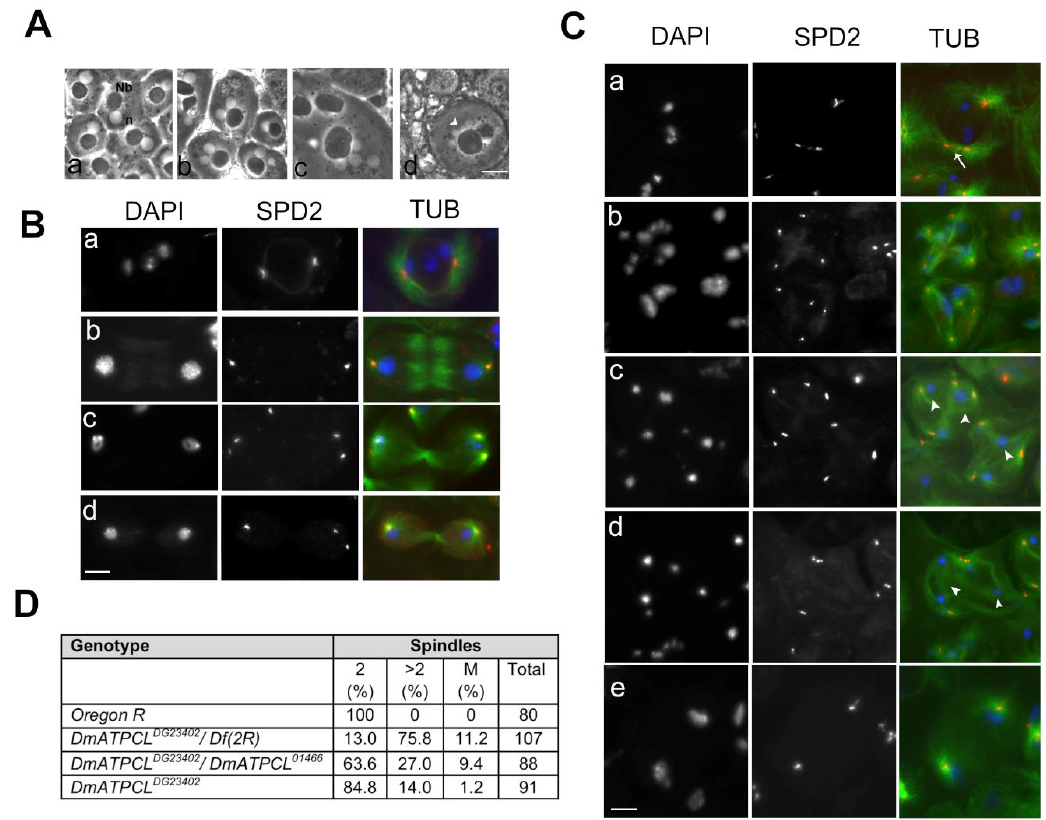
Figure 1. Loss of DmATPCL affects male meiosis. ( A ) Phase contrast images of onion stage spermatids from control ( Aa ) and DmATPCL mutant testes ( Ab – d ). Note that in DmATPCL mutant spermatids consists of a large nebenkern (Nb) associated to either two or four nuclei (n) in DmATPCL DG23402 / DmATPCL DG23402 combination ( Ab , c ) as well as to aneuploidy nuclei DmATPCL DG23402 /Df genotype (( Ad ), white arrowhead). ( B , C ) Immunostaining with anti-Spd2 (red) and anti-tubulin (green) in wild-type ( B ) and DmATPCL mutant ( C ) dividing meiotic cells. Panels in B show examples of control cells in prometaphase I ( Ba ), anaphase I ( Bb ), telophase I ( Bc ), and anatelophase II ( Bd ). DNA has been counterstained with DAPI. Note that depletion of DmATPCL induces premature centriole disengagement in primary spermatocytes (arrow in Ca ) that leads to the formation of multipolar spindles ( Cb – d ) in which chromosomes do not segregate properly (arrowheads). ( Ce ) Example of a dividing cell with an apparent normal bipolar spindle that lacks a central spindle and/or fails to contract but with daughter nuclei decondensed in a telophase state, indicating that central spindle fails to constrict during telophase. Bar = 10 μm. ( D ). Frequency of cells displaying irregular meiotic spindles. 2 = Spindles with 2 asters (normal); >2 = Spindles with more than 2 asters (multipolar); M = monopolar spindle; Df(2R) = Df(2R)Exel7138. The anti-Spd2 immunostaining of primary spermatocytes at stages S5-S6 (mature primary